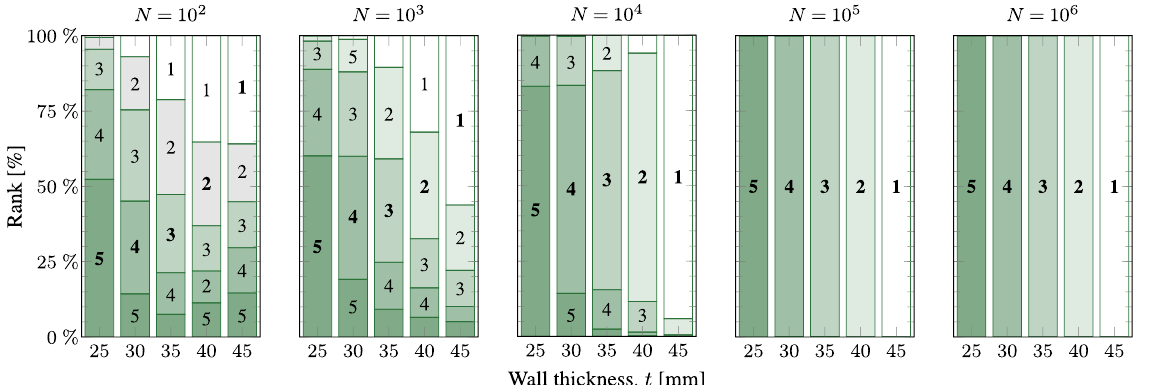
Figure 15. Ranking of five wall thicknesses on the basis of a 50-year stress level using an aggregation-before-fitting approach with a GEV fitted above a threshold with different sample sizes.